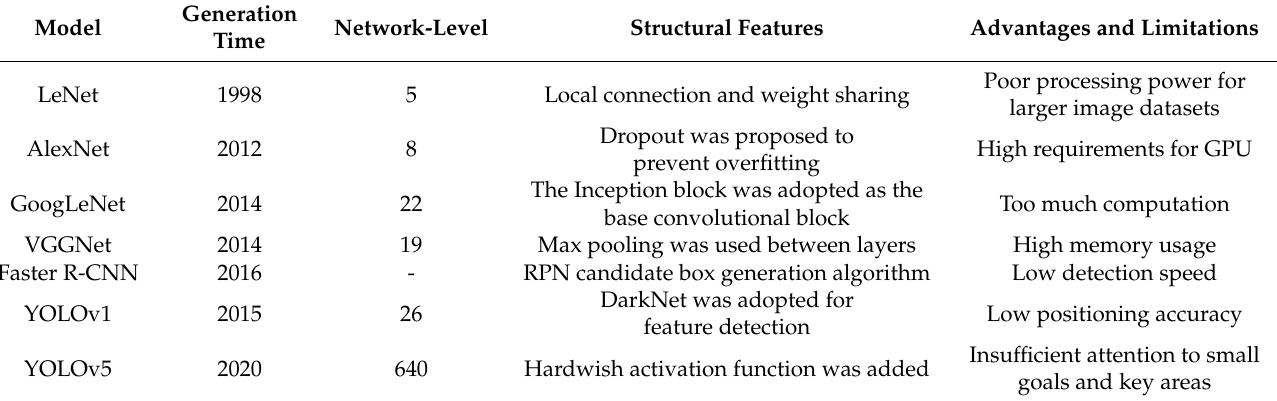
Table 1. Comparison of different network models (the generation time, network level, and structural features of different